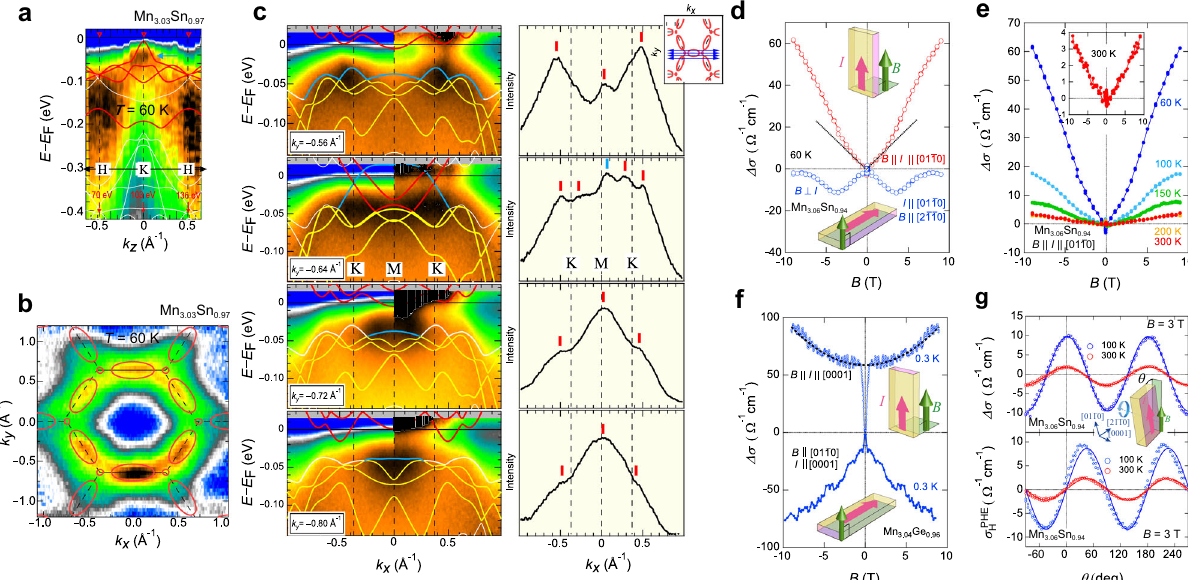
Fig. 5 ARPES study and the chiral anomaly in Mn 3 X ( X = Sn, Ge). a k z -dispersion along the H-K-H high-symmetry line (black arrows) obtained at 60 K by varying the incident photon energy h ν from 50 to 170 eV. The blue arrow marks the quasiparticle peak developed around K point. b ARPES intensity at E k – k h ν = 103 eV. The solid curves represent the Fermi surface predicted by the DFT calculation. c ARPES intensity maps in F in the x y -plane obtained with the E – k x -plane along the high-symmetry K-M-K direction at various k y obtained at 60 K. The original spectrum intensity (left) is compared to the intensity divided by the energy-resolution convoluted Fermi – Dirac (FD) function. The solid lines represent the calculated band dispersion, with the red and blue curves marking the electron and hole bands that form the Weyl points. Right: the anomalies in the corresponding momentum distribution curves (MDCs) are marked by the vertical color bars. d Field dependence of the magnetoconductivity in Mn 3 Sn for B || I (red) and B ⊥ I (blue) under a magnetic fi eld (cid:1) (cid:3) B k 01 (cid:1) 10 at 60 K. e Field dependence of the magnetoconductivity in Mn 3 Sn for B || I measured at various temperatures. f Field dependence of the magnetoconductivity for B || I and B ⊥ I and with I || [0001] measured at 0.3 K in Mn 3 Ge. The dashed line is a fi t to the B 2 dependence. g Angle dependence of the longitudinal magnetoconductivity (top) and the planar Hall effect (PHE) (bottom) in Mn 3.06 Sn 0.94 measured at 300 and 100 K under B = 3 T. The solid lines are the fi ts to the theoretical forms (see the main text for details). Adapted from ref. 8 , Springer Nature ( a – e